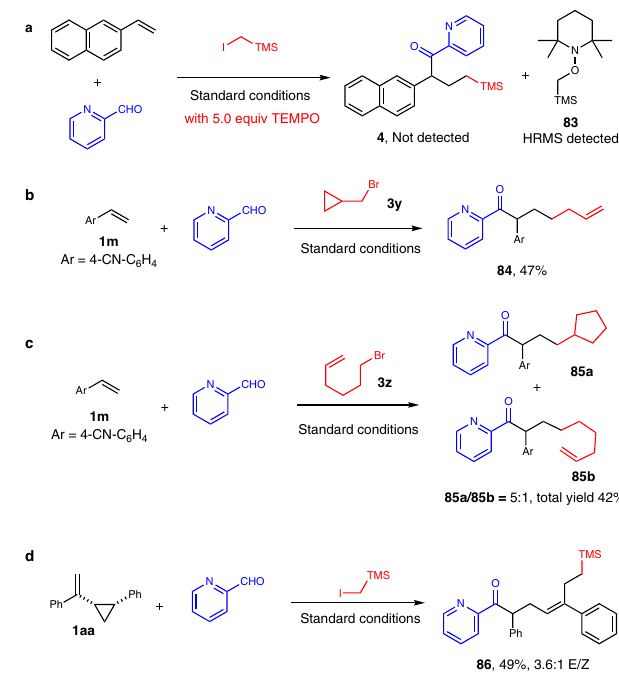
Fig. 6 | Mechanistic study. a Radical trapping experiment with TEMPO (2,2,6,6- tetramethylpiperidinooxy). b Radical clock experiment with (bromomethyl)cyclo- propane. c Radical probe experiment with 6-bromohex-1-ene. d Radical clock experiment with (1-(2-phenylcyclopropyl)vinyl)benzene.